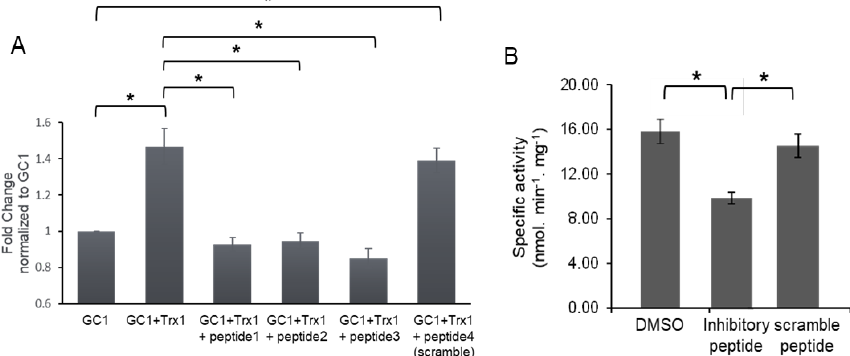
Figure 1. Inhibitory peptides block Trx1-dependent enhancement of NO-stimulated GC1 activity in an in vitro system ( A ) and cells ( B ). ( A ), Purified GC1 and Trx1 (molar ratio 1:7) were mixed in the absence or presence of 25 μ M for each peptide, GC1 activity was measured under basal (not shown) and stimulated (1 μM DEA-NO) conditions. Specific activity in nmol cGMP·min -1 ·mg -1 (Figure S3) was normalized against GC1 activity and expressed as fold change; n = 4 independent experiments, measured in duplicate; * p < 0.05. ( B ) COS-7 cells were transfected with GC1 and treated with 10 μM of peptide 3 (inhibitory peptide) and scramble peptide modified by the addition of a cell-penetrating peptide and the fluorophore FITC (Figure S2a). Peptide penetration and GC1 expression were verified by imaging and Western blotting (Figures S2b,c). n = 4 independent experiments, measured in duplicate; * p < 0.05. The inhibitory peptide had no effect under basal conditions (Figure S2d).